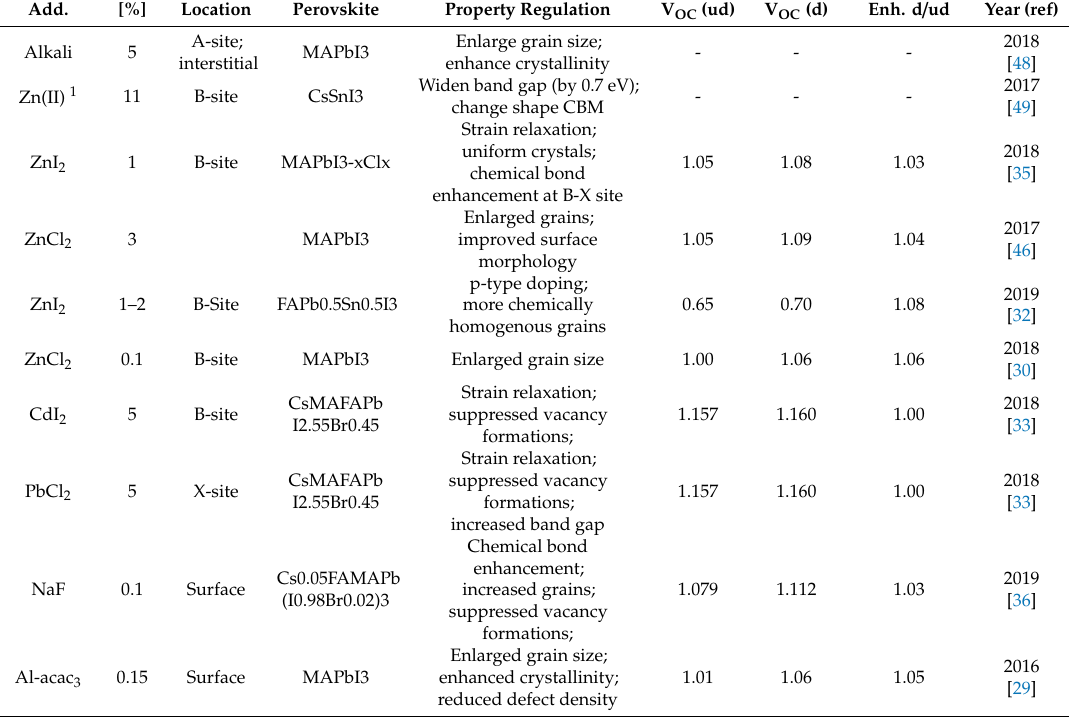
Table 2. The e ff ects of doping on perovskite properties. Dopants are reported as the additive ( = Add.), the content (%) is the amount that improved photoluminescence or e ffi ciencies the most, location of incorporation is given when experimentally / computationally determined, property regulations are mostly experimentally measured, the V OC is given for the undoped and doped perovskite (ud = undoped, d = doped), together with the enhancement factor (d / ud). The year is the year the article is published, reference is given. 1 marks a computational study. It has to be noted that various device architectures and perovskite compositions are compared. The property regulation and enhancement is however a generally observed e ff